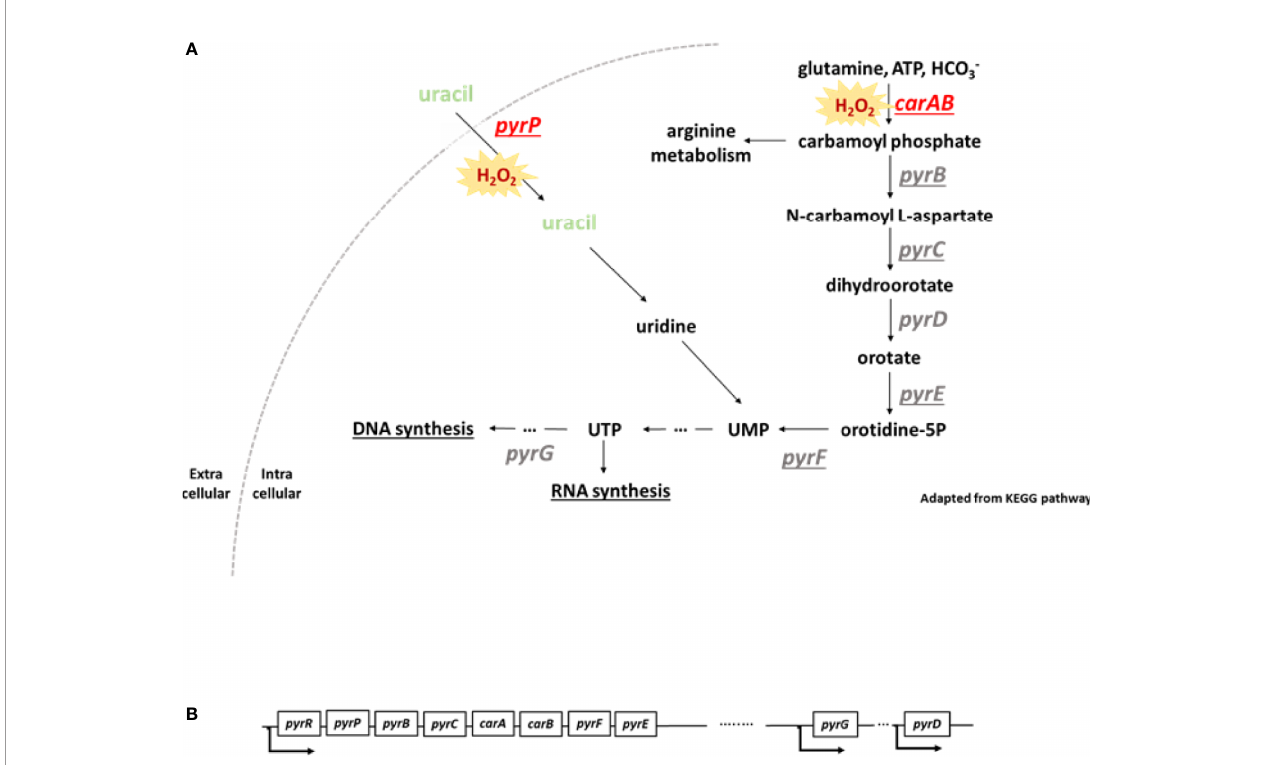
FIGURE 3 | pyr operon and scheme of pyrimidine biosynthesis pathway. (A) Under oxidative stress, genes involved in pyrimidine biosynthesis are downregulated. Loss of function of carA and pyrP leads to an alteration of bacterial fi tness. Pyrimidine metabolism is divided in two different pathways: the de novo and the salvage pathways. The de novo pathway uses glutamine, ATP and bicarbonate (HCO − 3 ) in the cell to produce uridine monophosphate (UMP). The salvage pathway uses extracellular uracil to generate UMP. Loss of function of carA and pyrP genes leads to an alteration of bacterial fi tness and a higher sensitivity to H 2 O 2 . UMP, uridine monophosphate, UTP, uridine triphosphate. The underlined genes are located on the same operon. This scheme was adapted from KEGG pathway. (B) Some of the pyr genes are located on an operon and transcribed from a single promoter. pyrG and pyrD are located further in the genome and transcribed with their own